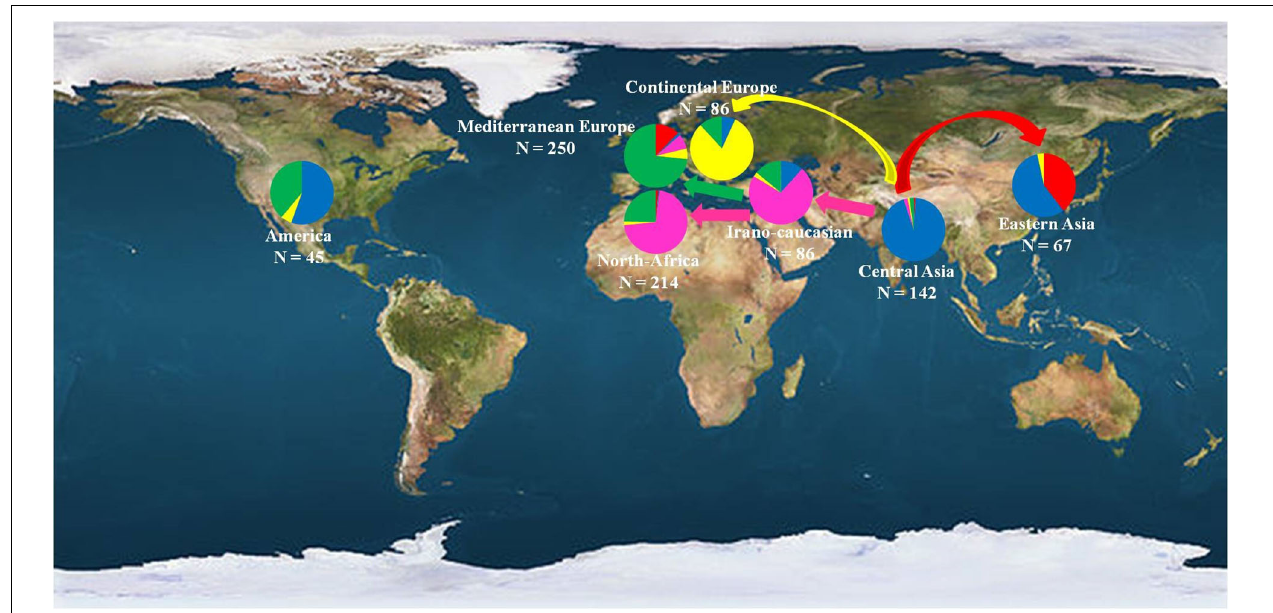
FIGURE 7 | Geographical distribution of the 890 investigated apricot accessions classified into the seven geographic origins. Color codes denotes the clusters identified by STRUCTURE analysis as reported in Figure 1 , with Cluster 1 in red, Cluster 2 in blue, Cluster 3 in pink, Cluster 4 in yellow, and Cluster 5 in green.